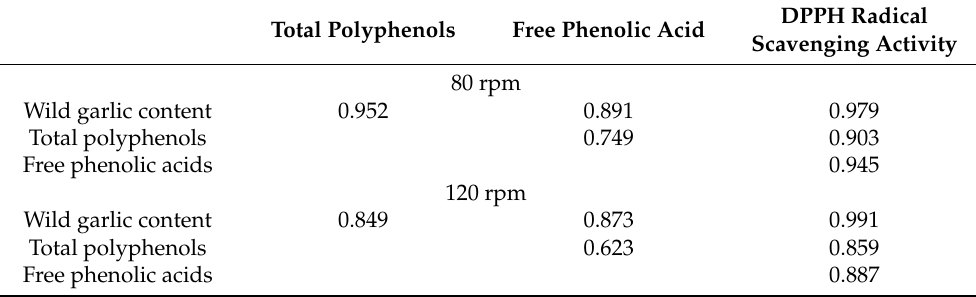
Table 4. Pearson’s correlation coefficients for snacks supplemented with wild garlic leaves addition. DPPH Radical Total Polyphenols Free Phenolic Acid Scavenging Activity 80 rpm Wild garlic content